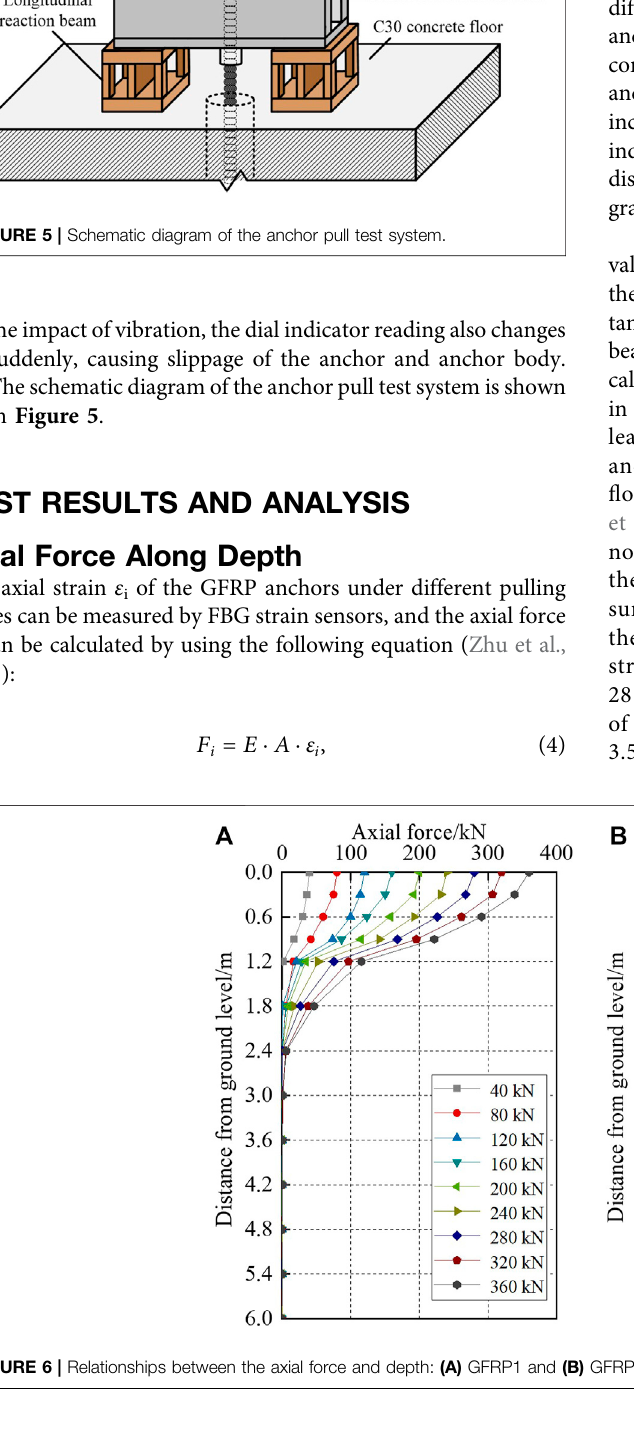
Frontiers in Materials |